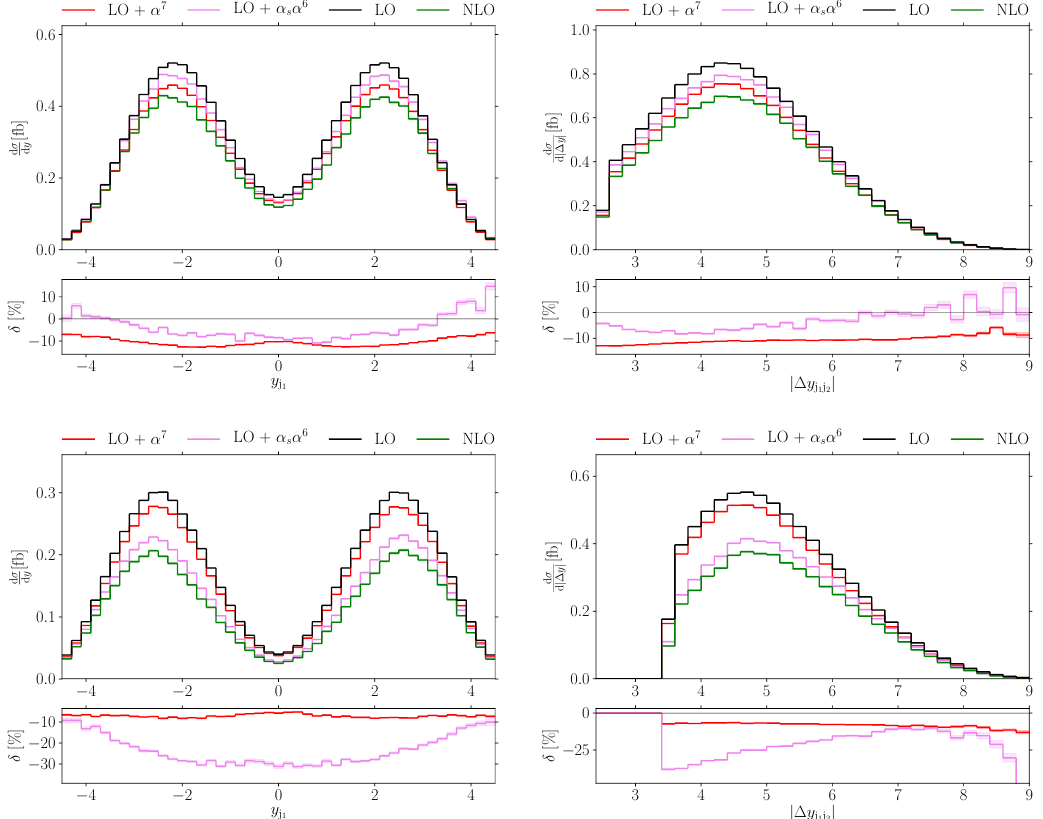
Figure 11. Differential distributions at NLO in the rapidity of the hardest jet (left) and the rapidity difference between the two tagging jets (right) in the VBS (top) and the Higgs setup (bottom). The (cid:0) (cid:1) upper panels show the absolute EW contribution at α 6 , the sum of the EW contribution and the O (cid:0) (cid:1) EW corrections of α 7 , the sum of the EW contribution and the QCD corrections of O and the sum of all three contributions. The lower panels show the relative EW and QCD corrections normalised to the LO EW contribution. Shaded bands denote integration